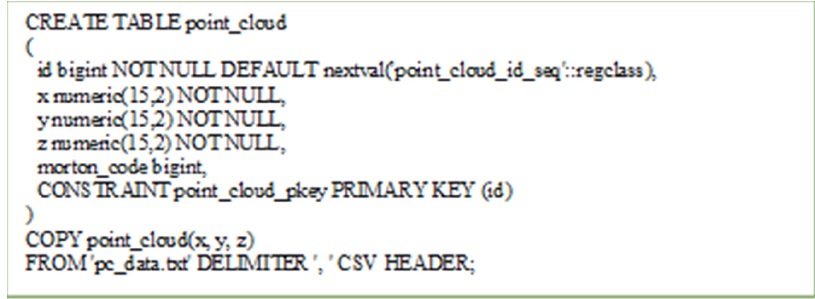
Figure 10. SQL command for data import.